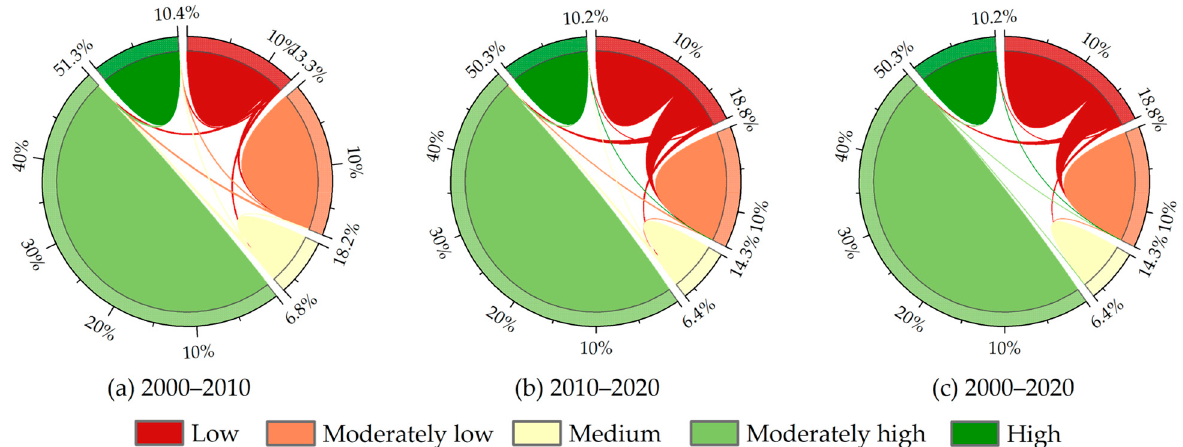
Figure 5. The magnitude of change and flow direction of each grade of habitat quality in Guiyang city from 2000 to 2020.